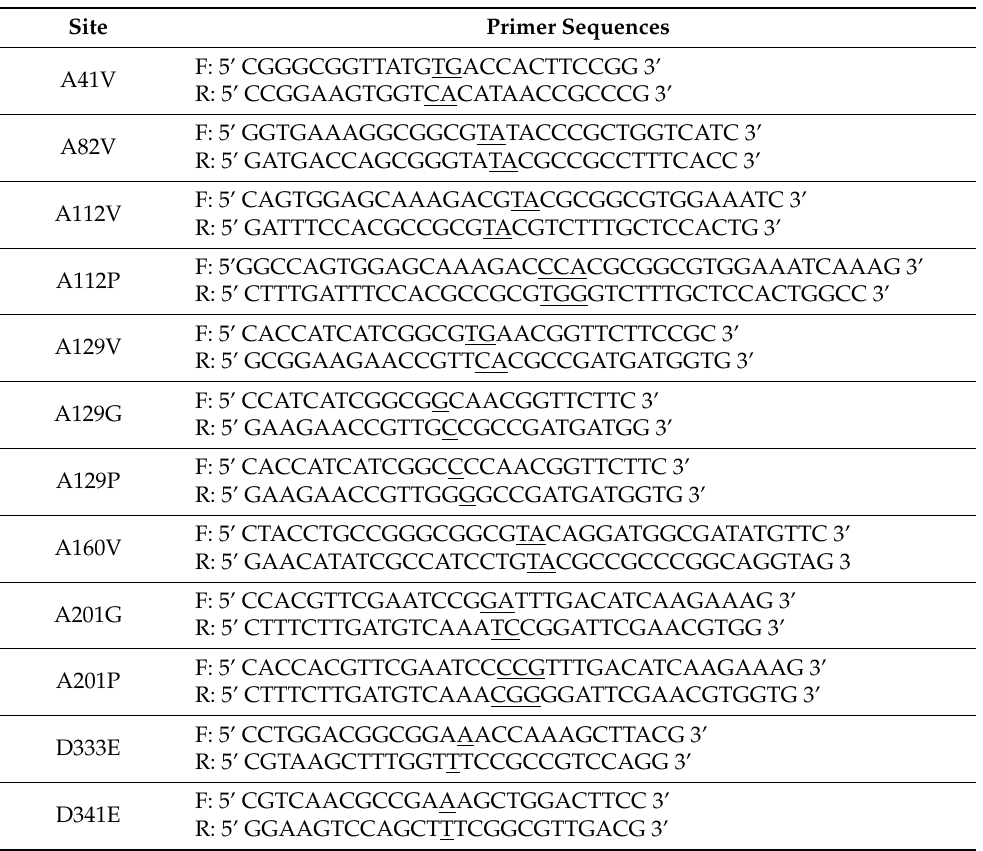
Table 1. Mutation sites and their